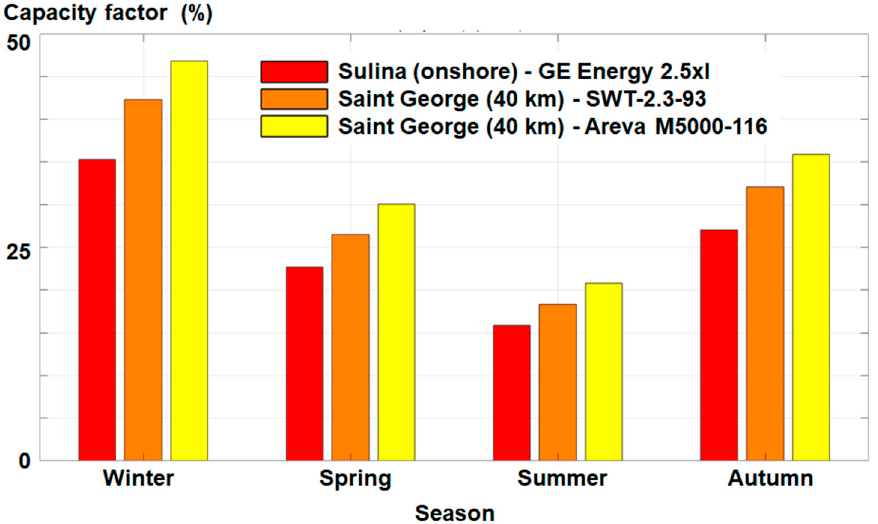
Figure 7. Seasonal distribution of the capacity factor (average values), corresponding to the sites Sulina onshore (0 km) and Saint George (40 km from the shore).